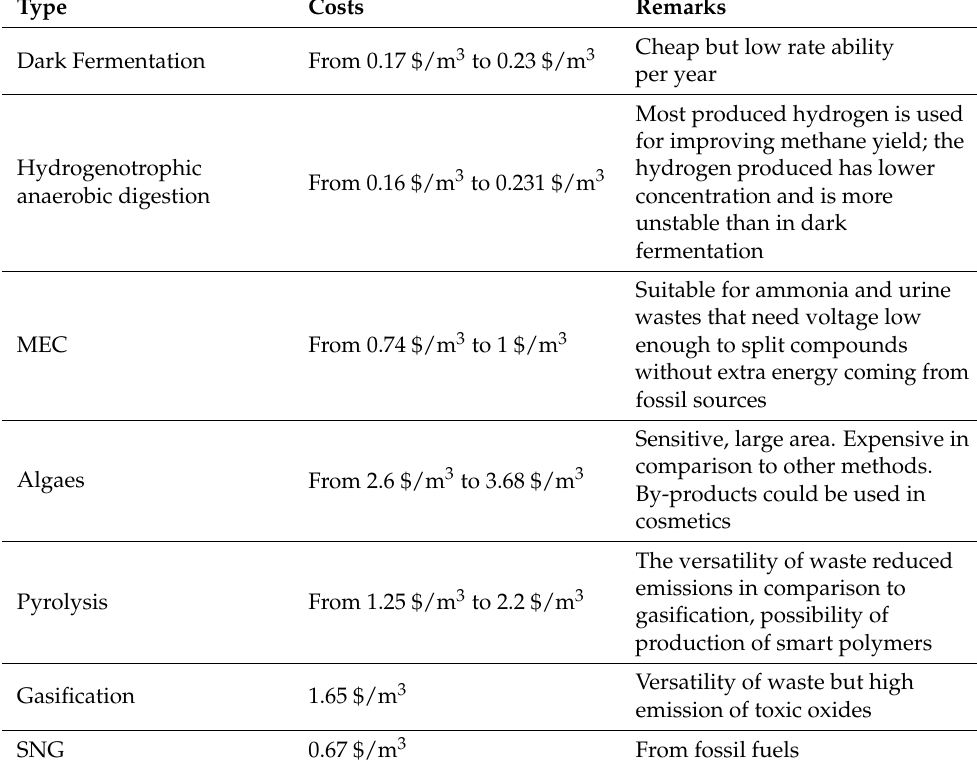
Table 2. Costs of different hydrogen production methods